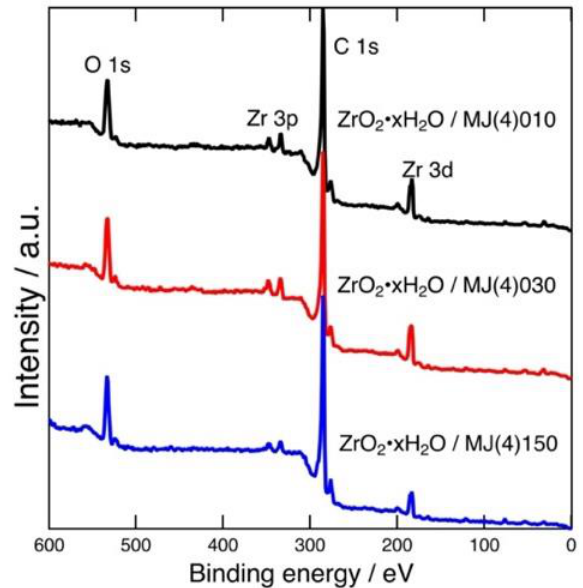
Figure 1. Wide-scan XPS of the prepared adsorbents: ZrO 2 · xH 2 O / MJ(4)010 ( black ), ZrO 2 · xH 2 O / MJ(4)030 ( red ), and ZrO 2 · xH 2 O / MJ(4)150 ( blue ).